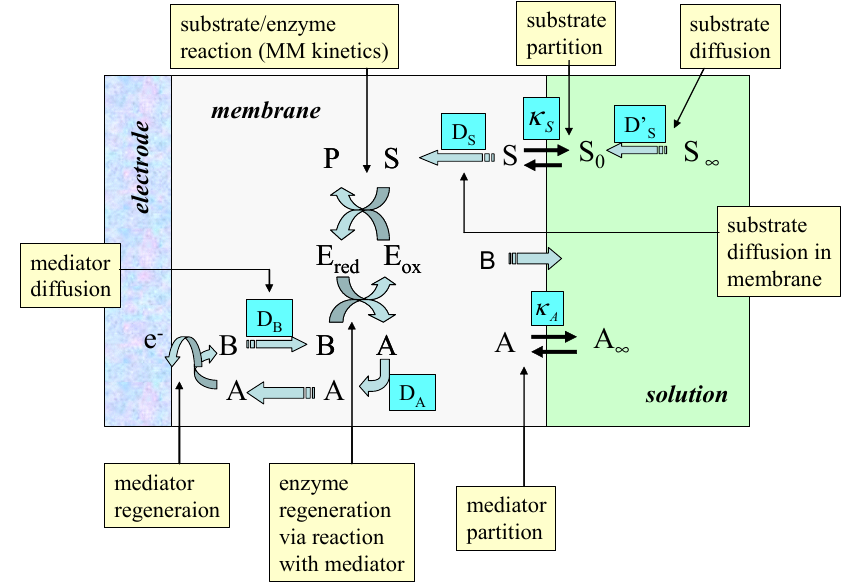
Figure 1. Schematic of a typical enzyme membrane electrode illustrating the various transport and kinetic